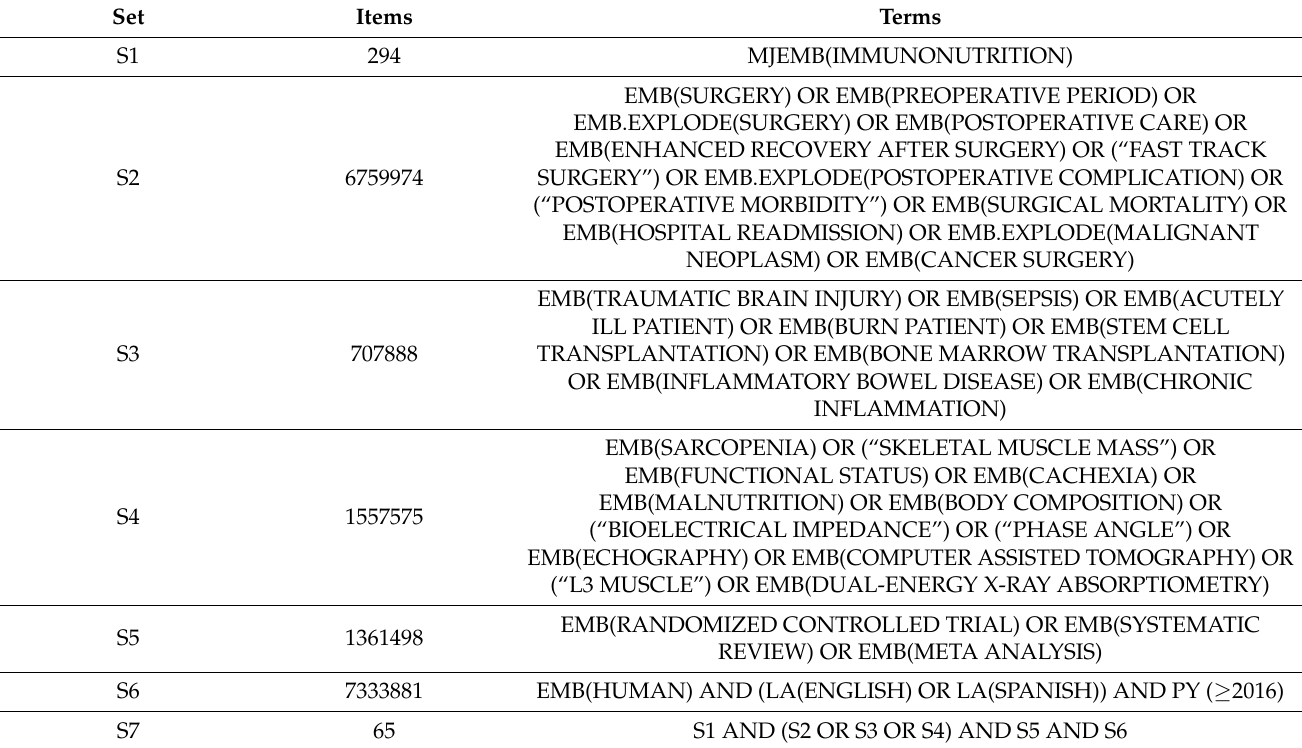
Table 1. The search strategy design. Search strategy used to develop the systematic